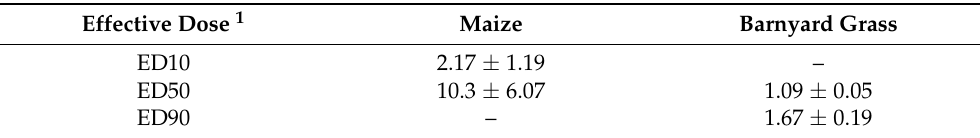
Table 4. Effective doses (ED) of peppermint nanoemulsions (% content of peppermint oil and surfactant ± standard deviation) causing 10, 50, and 90% of necrosis as assessed for maize and barnyard grass based on the drc analysis.